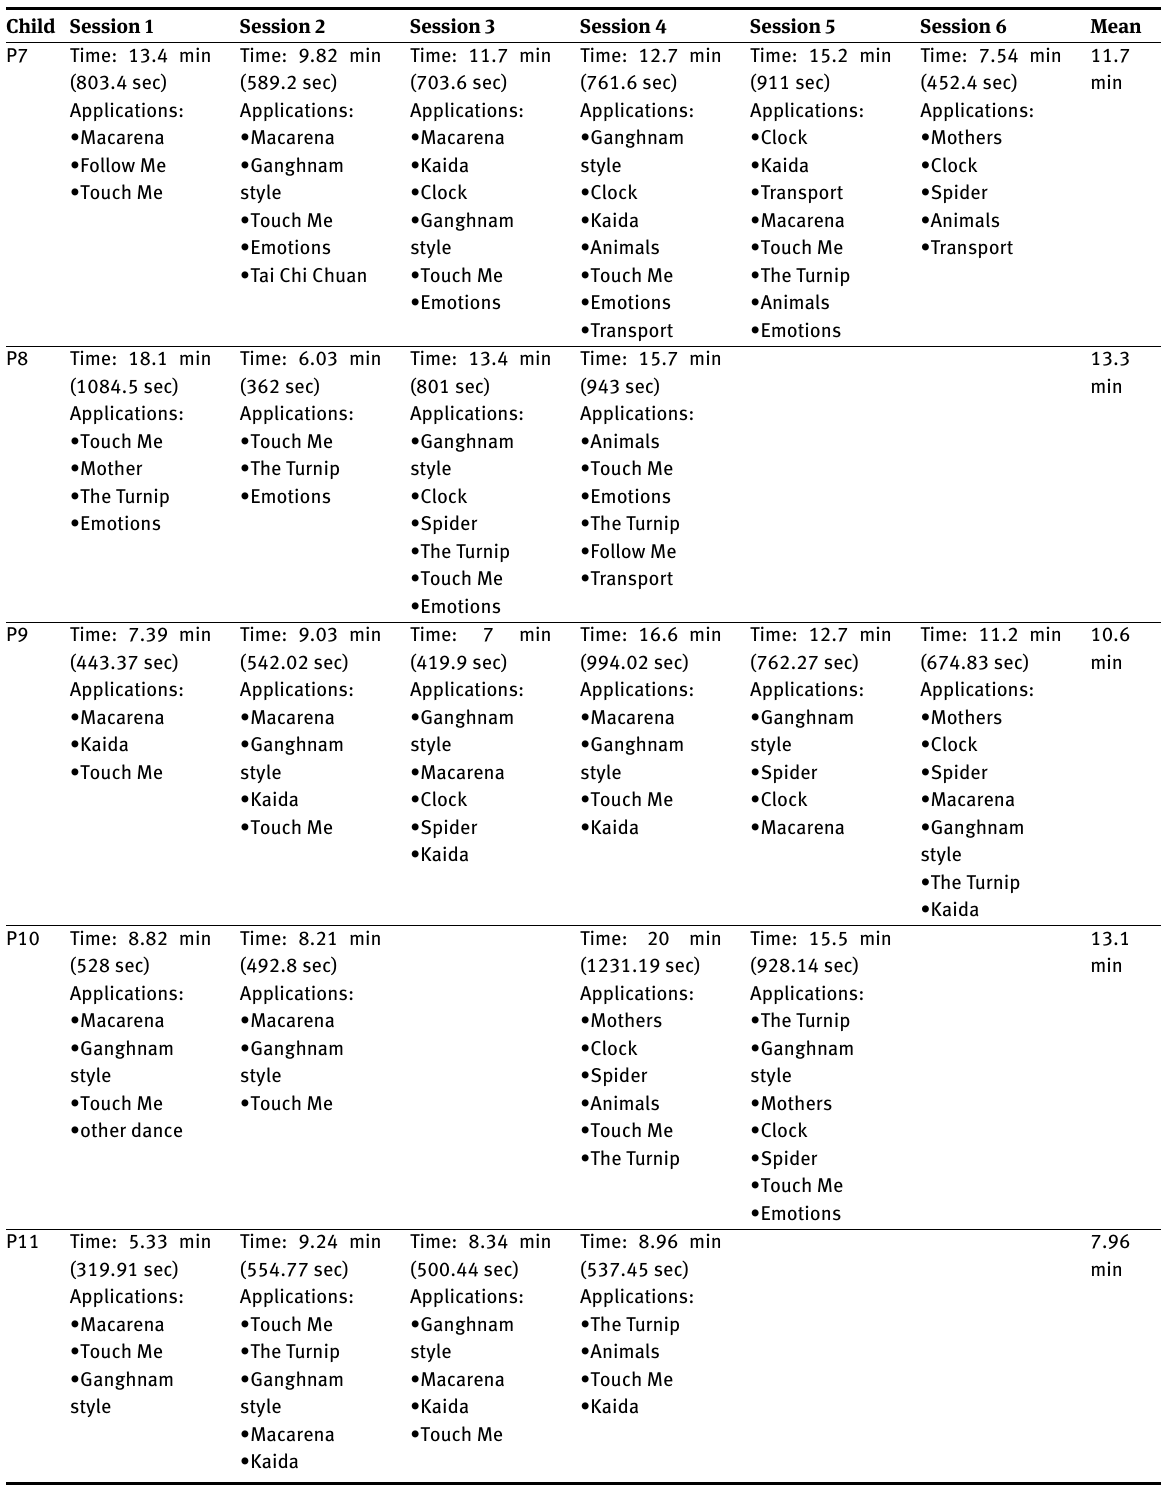
Table 2 Applications used for each child in each section during ID Phase